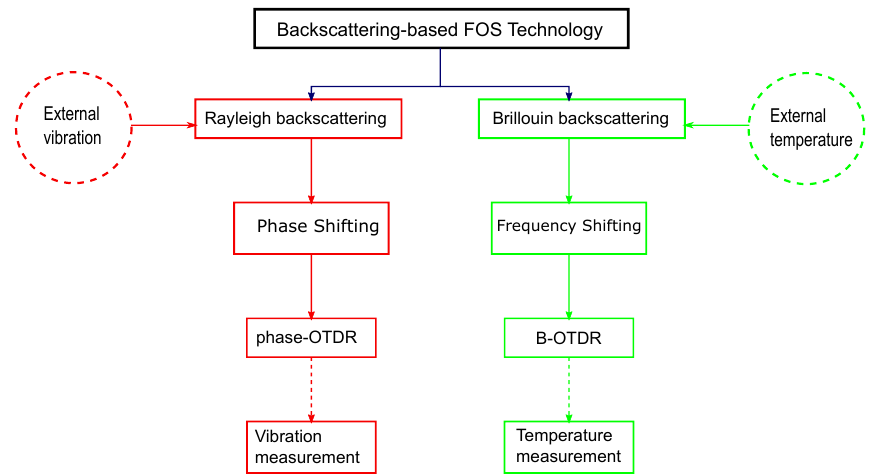
Figure 7. Flow chart displaying the φ -OTDR and B-OTDR scattering techniques for vibration and temperature